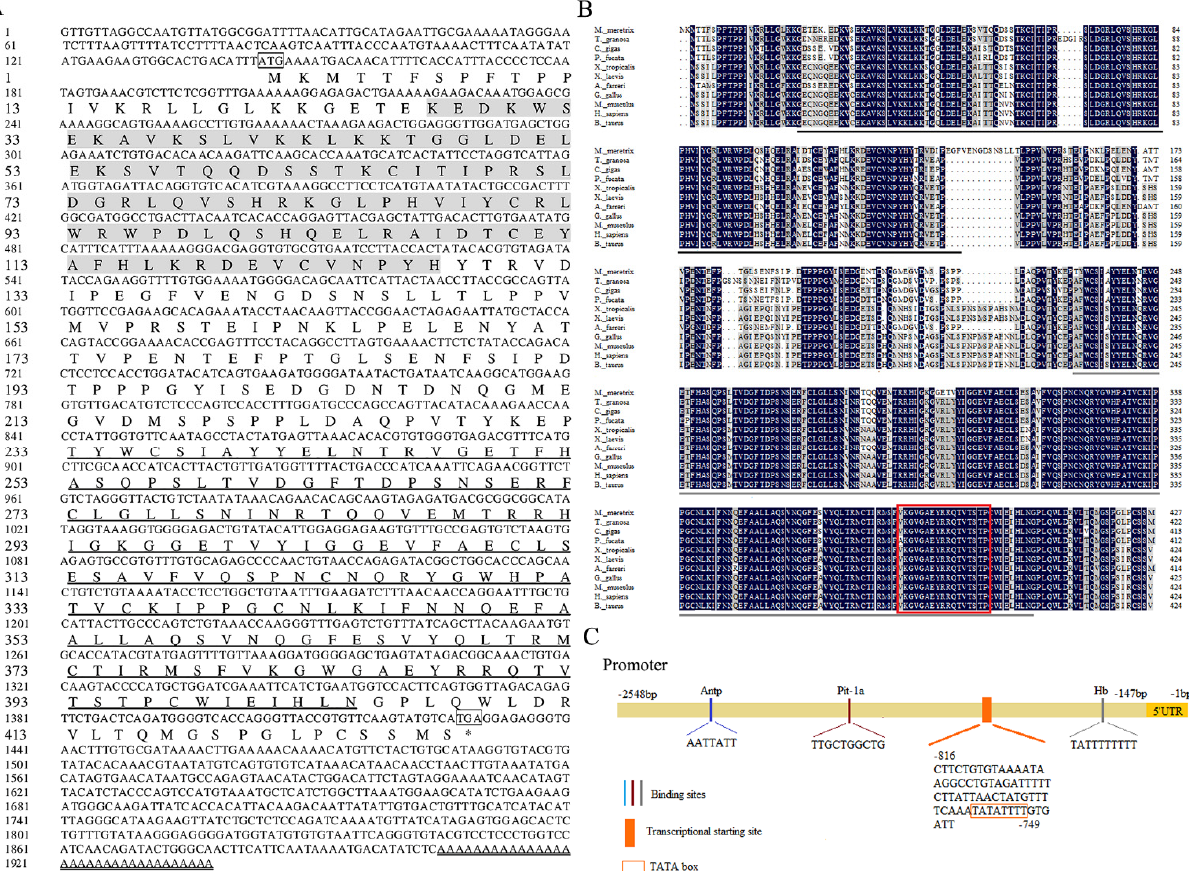
Figure 1. Sequence analysis of the Mm-Smad3 gene. ( A ). The full length of cDNA and deduced amino acid sequence of Mm-Smad 3. The frames represented the start codon, the stop codon, and the polyadenylation signal sequence. The double line is the polyA tail. The * represents the end of the protein translation. The double underlined bold part is the functional domains of MH1. The bold underlined part is the functional domains of MH2. ( B ). Multiple alignments of amino acid sequences of Smad3 from M. meretrix and other species. Among these, the completely (=100%), strongly ( ≥ 75%), and weakly ( ≥ 50%) conserved residues are shaded in black, dark grey, and light gray, respectively. The black and grey line represents the domain MH1 and MH2, respectively; the red box is the L3loop sequence. ( C ). Structure of the Mm-Smad 3 promoter. Antp, Pit-1a, and Hb are transcription factors predicted to be associated with growth.